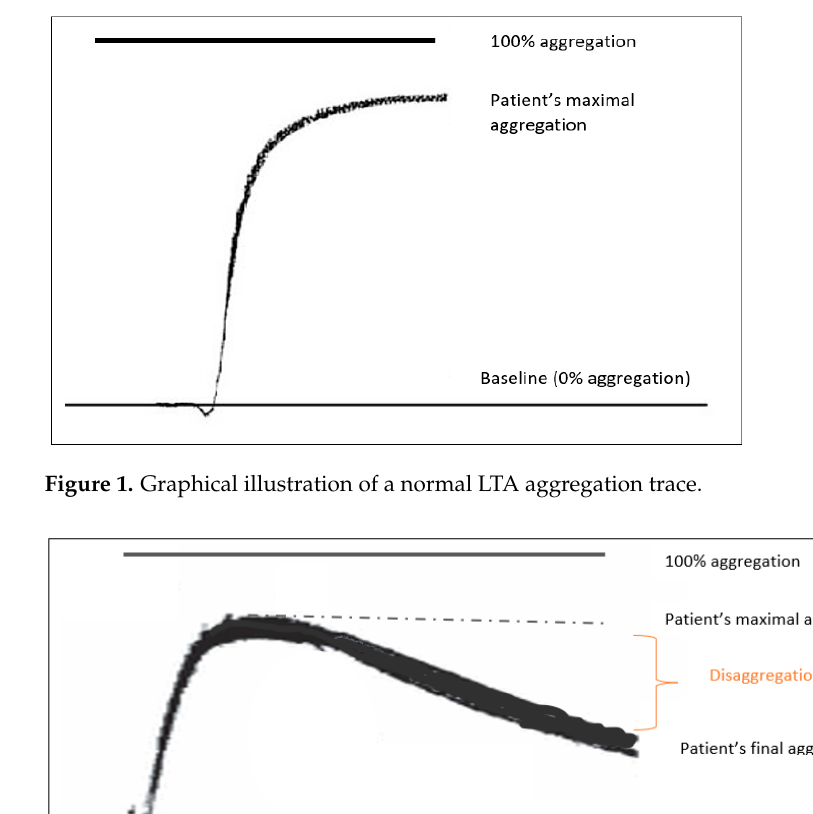
Figure 1. Graphical illustration of a normal LTA aggregation trace.